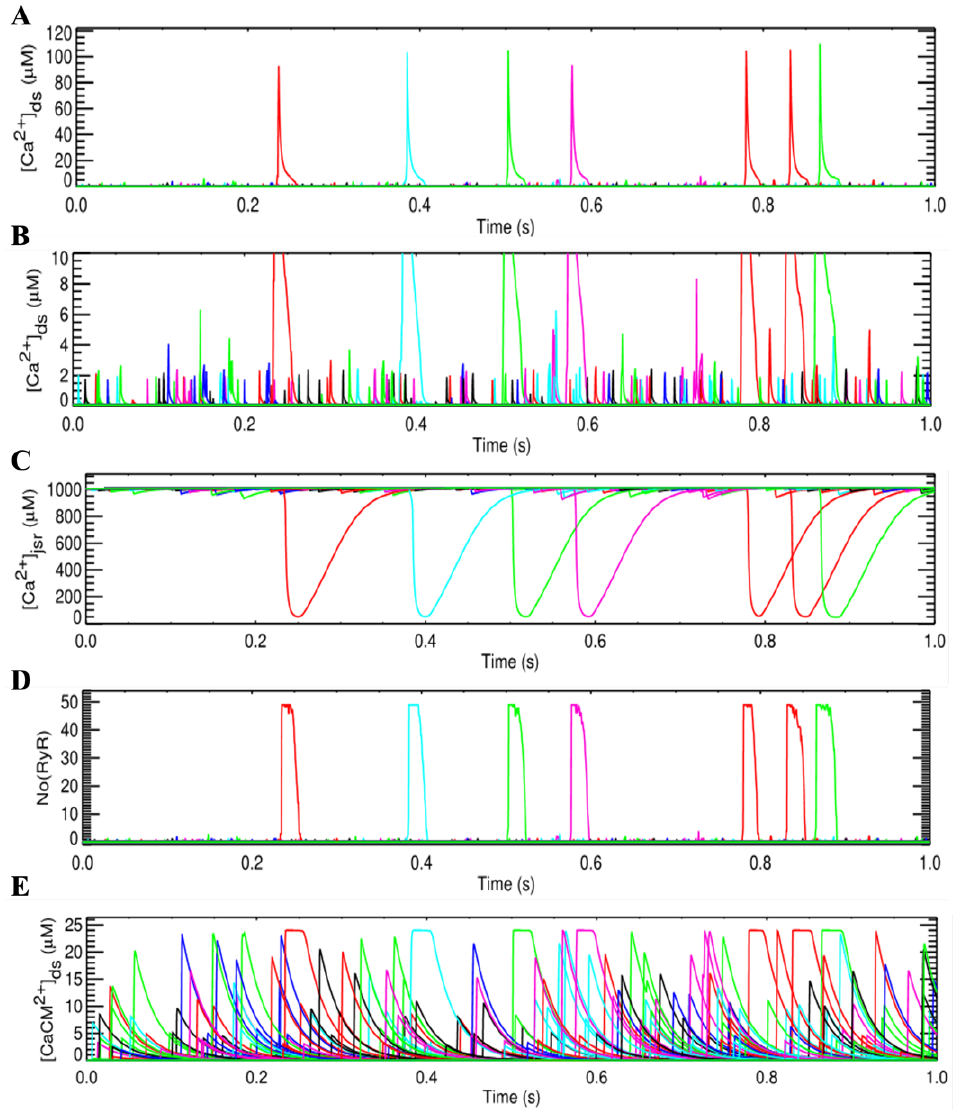
Figure A1. Calcium in the subspaces during ( A ) Ca 2+ sparks and ( B ) Ca 2+ quarks, ( C ) Dynamics of jSR Ca 2+ release, ( D ) Number of RyR openings, ( E ) Ca 2+ -bound calmodulin complex.